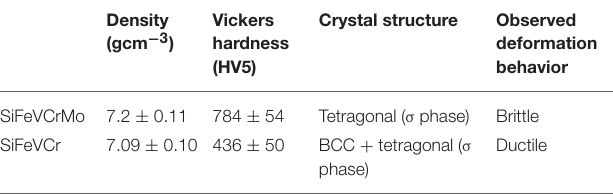
TABLE 3 | Density and Vickers Hardness values of the as-prepared